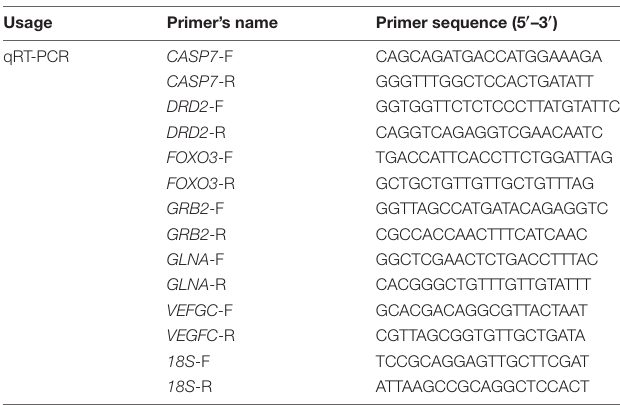
TABLE 1 | Primer sequences used for qRT-PCR. Usage Primer’s